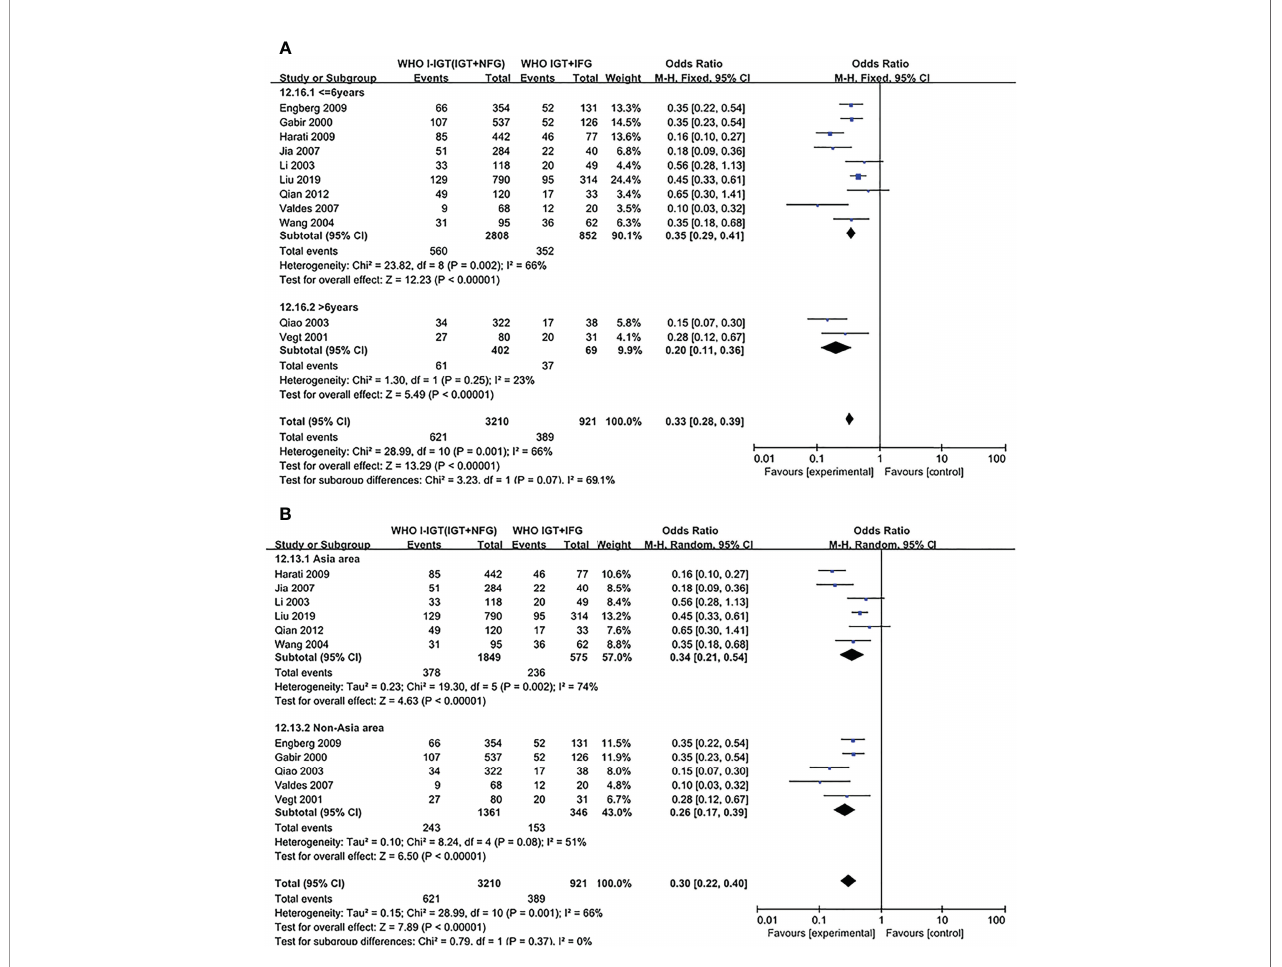
FIGURE 4 | Subgroup analysis was performed according to follow-up duration (A) and study location (B) in WHO 1999 groups. Subgroup analysis showed that it did not affect the fi nal outcome. 95% CI, 95% con fi dence interval; I-IGT, isolated impaired glucose tolerance; IGT+IFG, impaired fasting glucose combined with impaired glucose